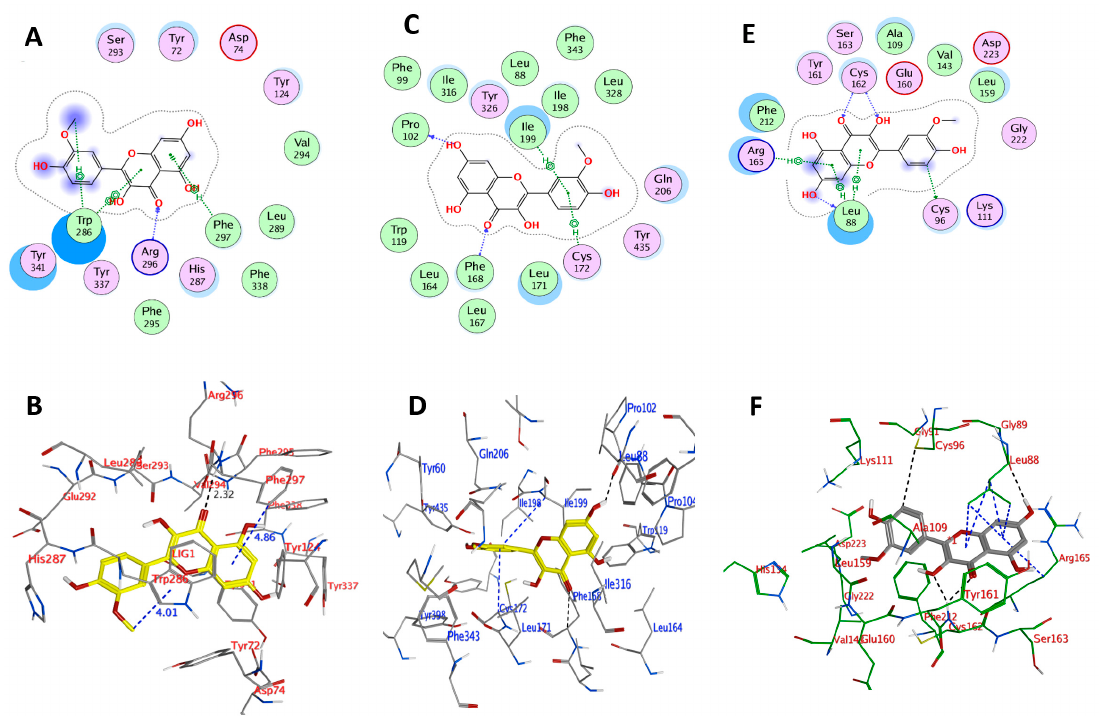
Figure 7. Docked conformation of IR within the binding pocket of AChE, MAO-B, and PLK2 as depicted in ( A , C , E ) for 2D docking poses; and in ( B , D , F ) for 3D docking poses, respectively. The active site of PLK2 (PDB ID: 4I5P) is mainly composed of the amino acid residues Leu88, Cys96, Ala109, Lys111, Val143, Leu159, Glu160, Cys162, and Phe212 [45]. The bind ‐ ing energy and polar/nonpolar interactions were considered adequately in one docked pose of the most active compound IR3G. This docked pose was chosen from 100 confor ‐ mations and possessed binding energy of − 7.734 kcal/mol, generating 4H ‐ bond interac ‐ tions with the active site residues (Table 2 and Figure 6). The hinge region residues Asp223, Asn210, Gly209, and Cys96 created four H ‐ bond interactions with four hydroxyl groups surrounding the glucopyranose ring of the ligand IR3G. Furthermore, IR3G inter ‐ acts with Leu88 and Arg165 through pi–H. In addition, although IR interacts with the active site residues, its efficient docked pose demonstrated binding energy of − 6.432 kcal/mol, indicating the capability of making 4H ‐ bond interactions with the PLK2 hinge region residues (Table 2 and Figure 7). It has been observed that the interaction between the ligand and the hinge residue Cys172 is critical for binding. The binding patterns of IR3G and IR were found to be comparable to the binding patterns reported in the co ‐ crys ‐ tallized inhibitor of PLK2 in the study, supporting the selected pose of these compounds. IR3G and IR were thus found to dock with negative binding energy, highlighting their potential binding affinity for the active sites of the PDB ‐ linked targets (AChE, MAO ‐ B, and PLK2). Based on the above findings, the selected docked conformations of IR3G and IR with the three target proteins were used in the following MD simulation study. 2.3.2. MD Simulation Study of Protein–Ligand Complexes MD simulation is a sophisticated computational method that can disclose the precise molecular interactions between the target protein and inhibitor at the atomic level [46]. To better evaluate the possible binding mode of IR3G or IR into AChE, MAO ‐ B, and PLK2 binding sites as predicted by the docking study, MD simulation on the ligand–protein complexes was performed as follows. A completely solvated system containing explicit water molecules and ions was produced and optimized using energy minimization; the